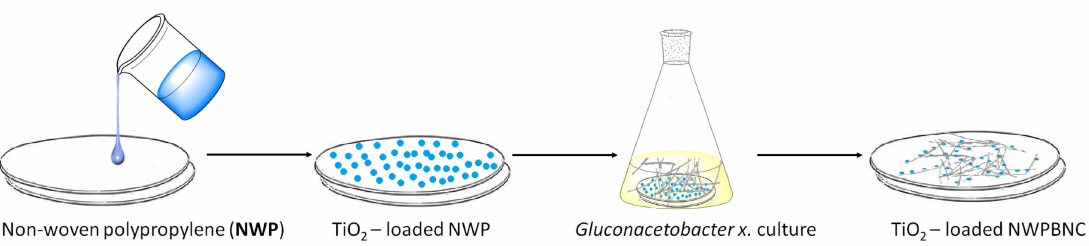
Figure 2. Preparation process of TiO 2 -loaded NWPBNC composite